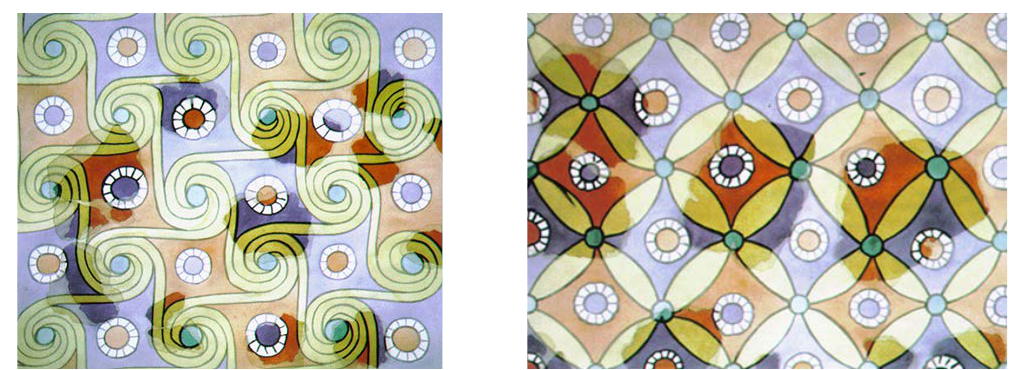
Figure4-9 ceiling Room L5, Amenhotep III palace.